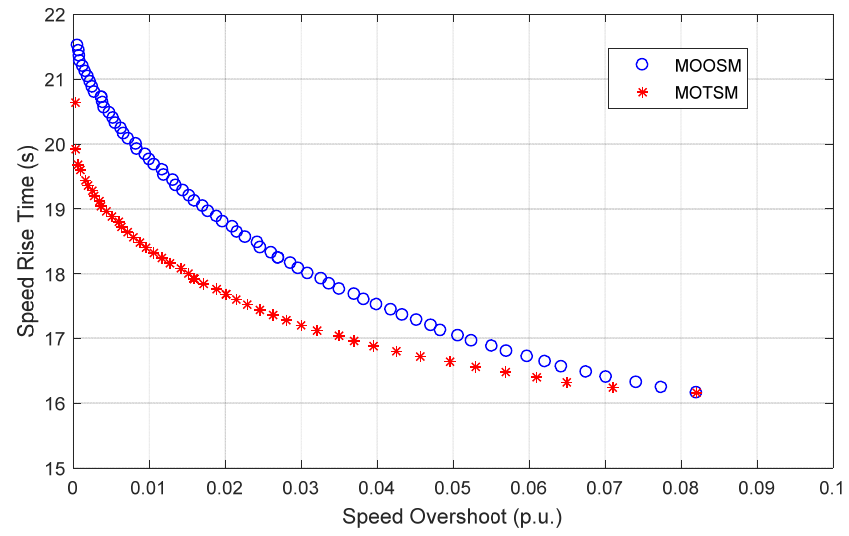
Figure 9. The domination relations of two Pareto Fronts.